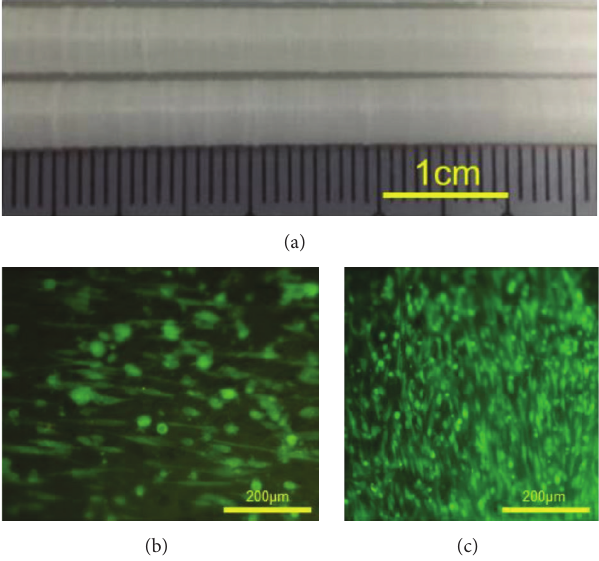
Figure 5: SMC seeding of a PLC prosthesis. A PLC tube was coated with PCL melt spun fiber (a), SMCs were seeded at high concentration (5 × 10 6 cells/mL) on fiberless (b) and fiber coated (c) tubes, and images were recorded 5 days after